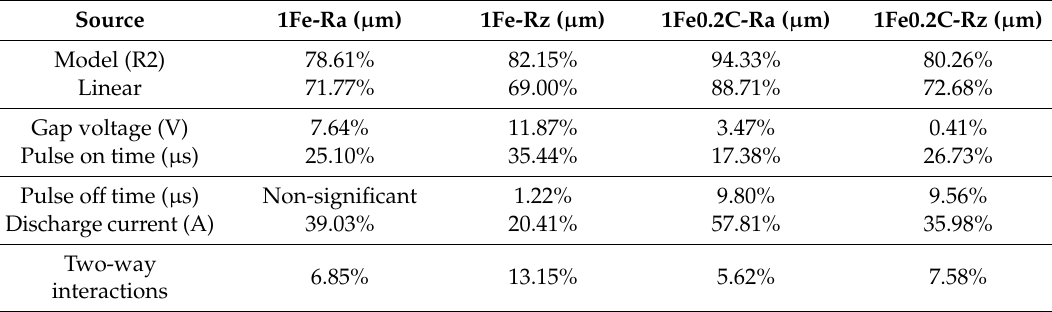
Table 5. Contributions of the variability of individual predictors to the overall variability of the modelled characteristic.